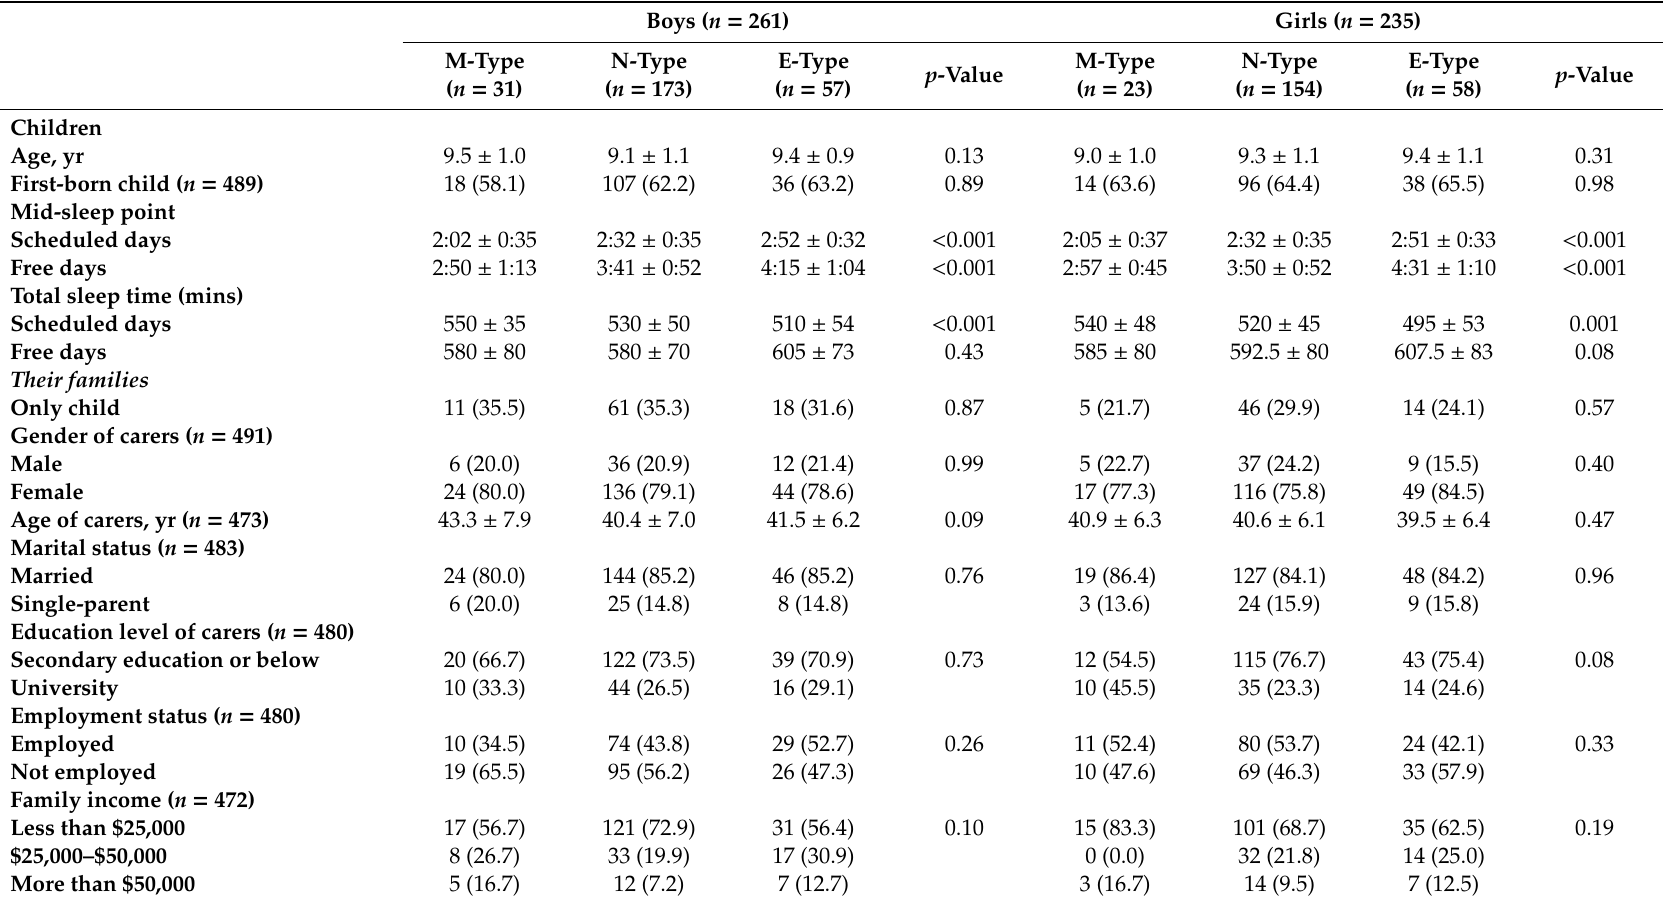
Table 1. Socio-Demographic information of the included children and their families, by sex ( N =